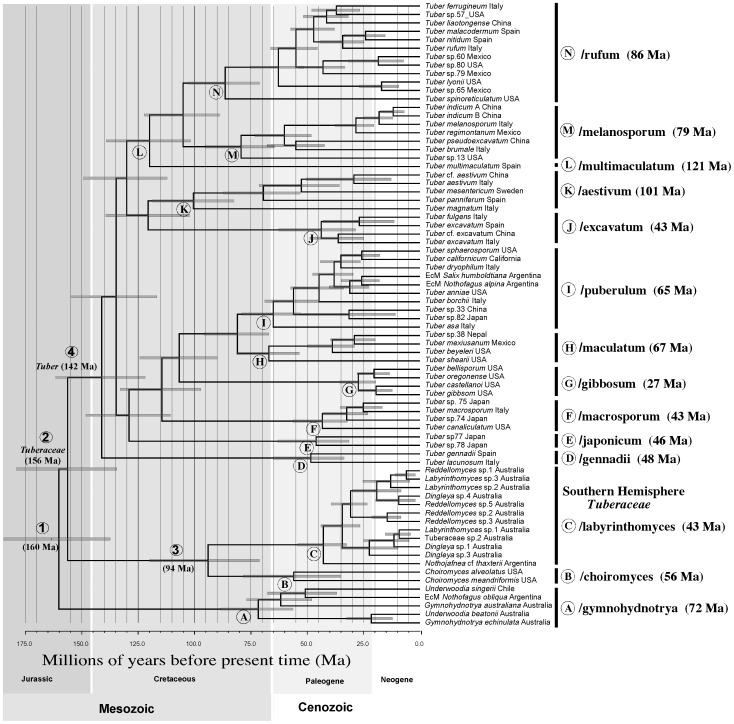
Bayesian Divergence Time Estimates for Truffles.The maximum clade credibility chronogram estimated in BEAST is shown with nodes placed at the median age. Node bars (grey) represent the node age 95% highest posterior density (HPD) for nodes receiving at least 50% Bayesian posterior probability. The median age is provided for labeled nodes (A–P) that are discussed in the text and node age parameters are presented in Table 1.